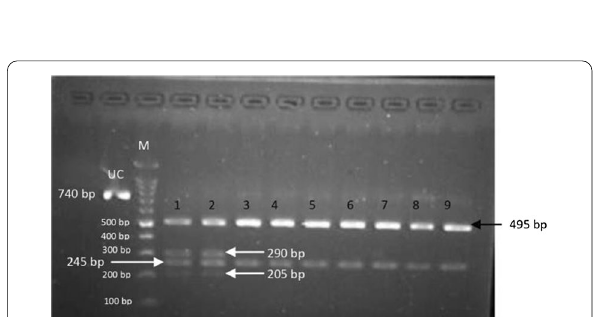
CT, lane 6 TT M marker = = =